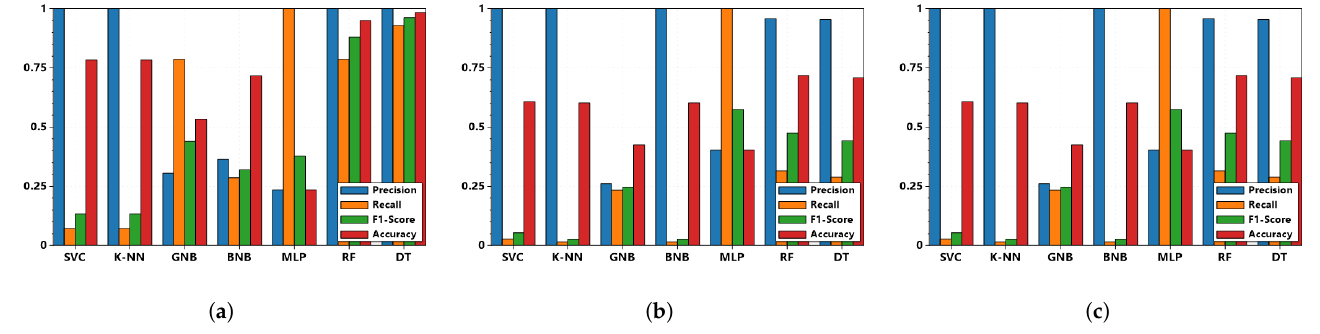
Figure 6. Precision, recall, F1 score, and accuracy obtained based on the pignistic score from three different rules of combination: ( a ) disjunctive; ( b ) conjunctive; ( c ) cautious conjunctive; tested with UC1, 30 s polling interval and 10 polled